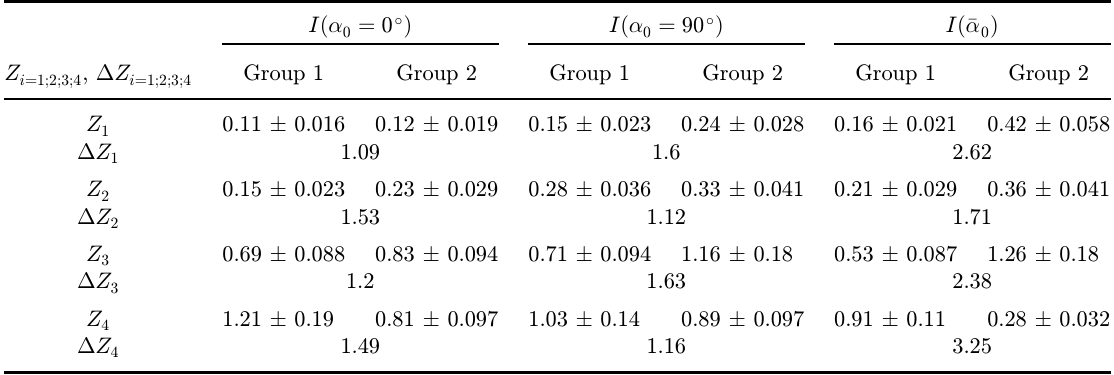
Table 1. Statistical ( Z i ) parameters of distributions I ð (cid:4) 0 Þ of histological sections of biopsy of cervix uteri ¼ 1 ; 2 ; 3 ; 4 endometrium of Group 1 (dysplasia) and Group 2 (cervical microinvasive